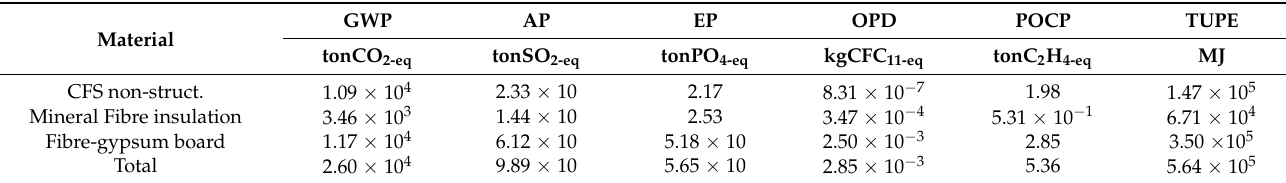
Figure 12. LCIA results: non-load-bearing walls. Table 13. Results of Life Cycle impact assessment: non-load-bearing walls.